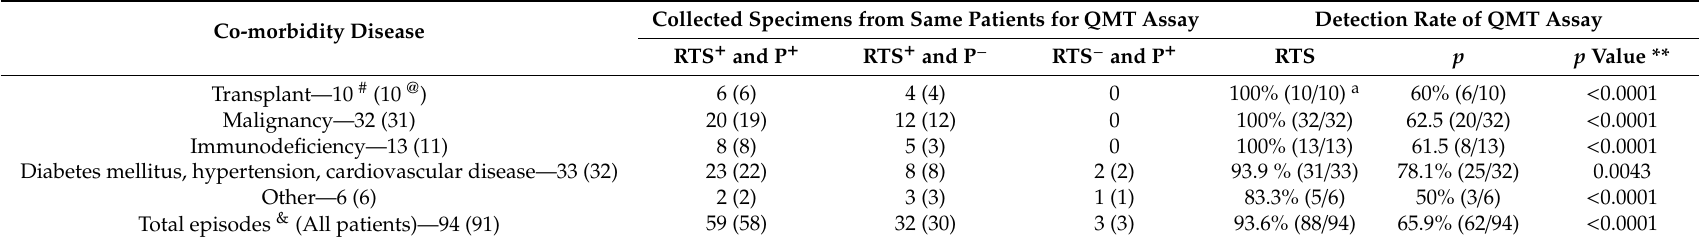
Table 4. CMV nucleic acid detected in simultaneous specimens of respiratory tract and plasma in patients with respiratory symptoms by QMT assay. Co-morbidity